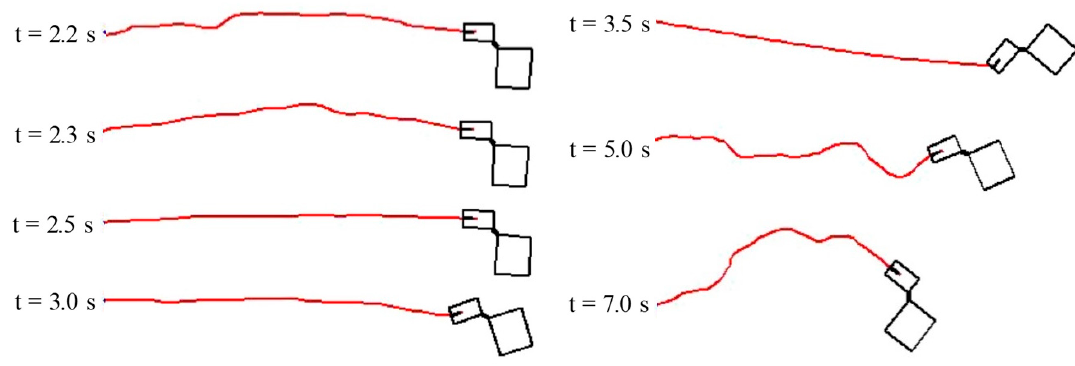
Figure 18. Shape of the system during tether winding (without control).